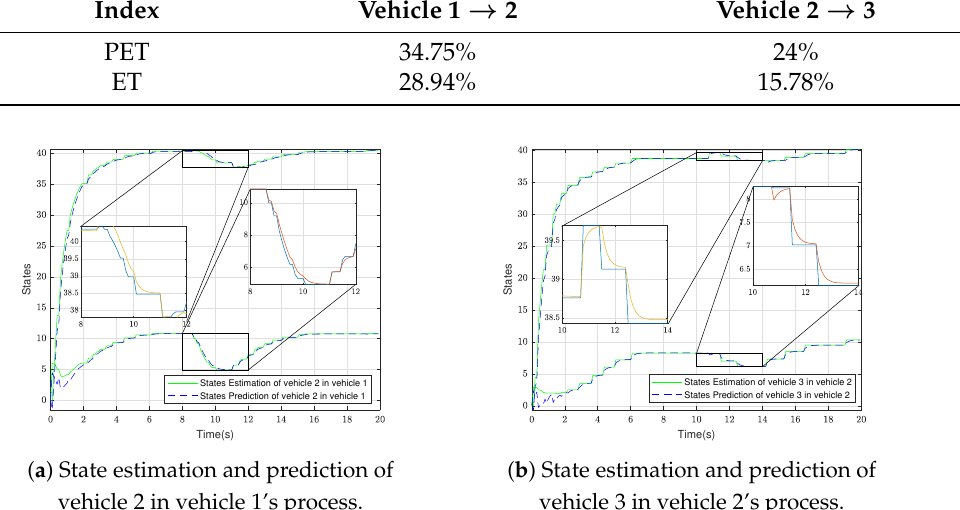
Figure 6. Distributed state estimation and prediction in